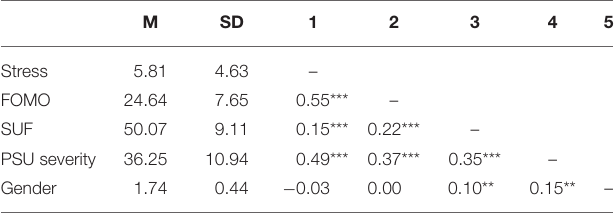
FIGURE 1 | Hypothetical model diagram.